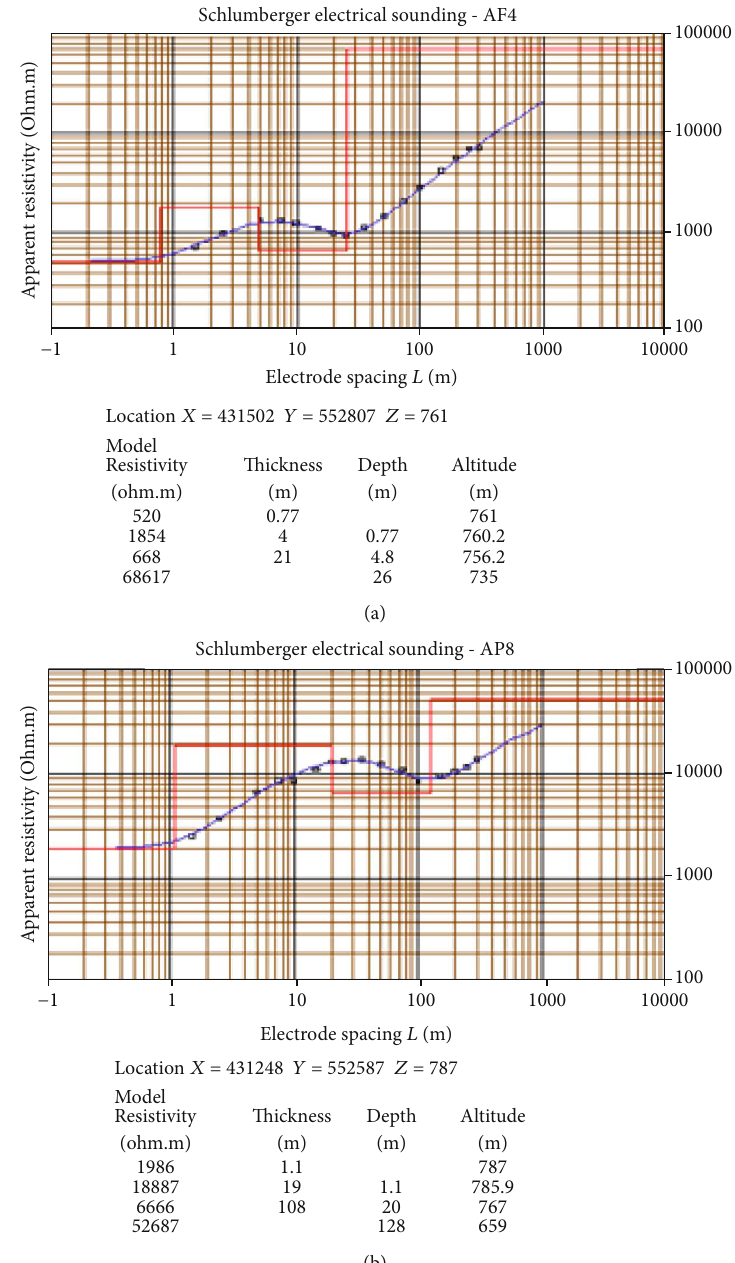
Figure 11: (a, b) Sounding curves (AF